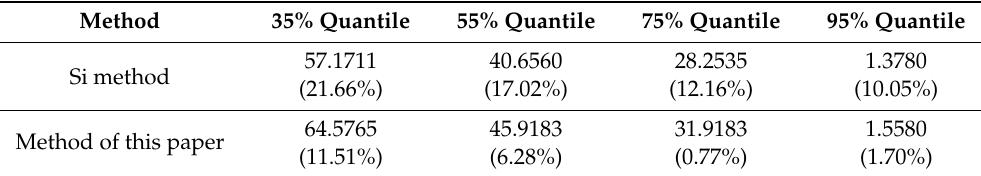
Table 5. RUL Prediction and RE of the two methods.